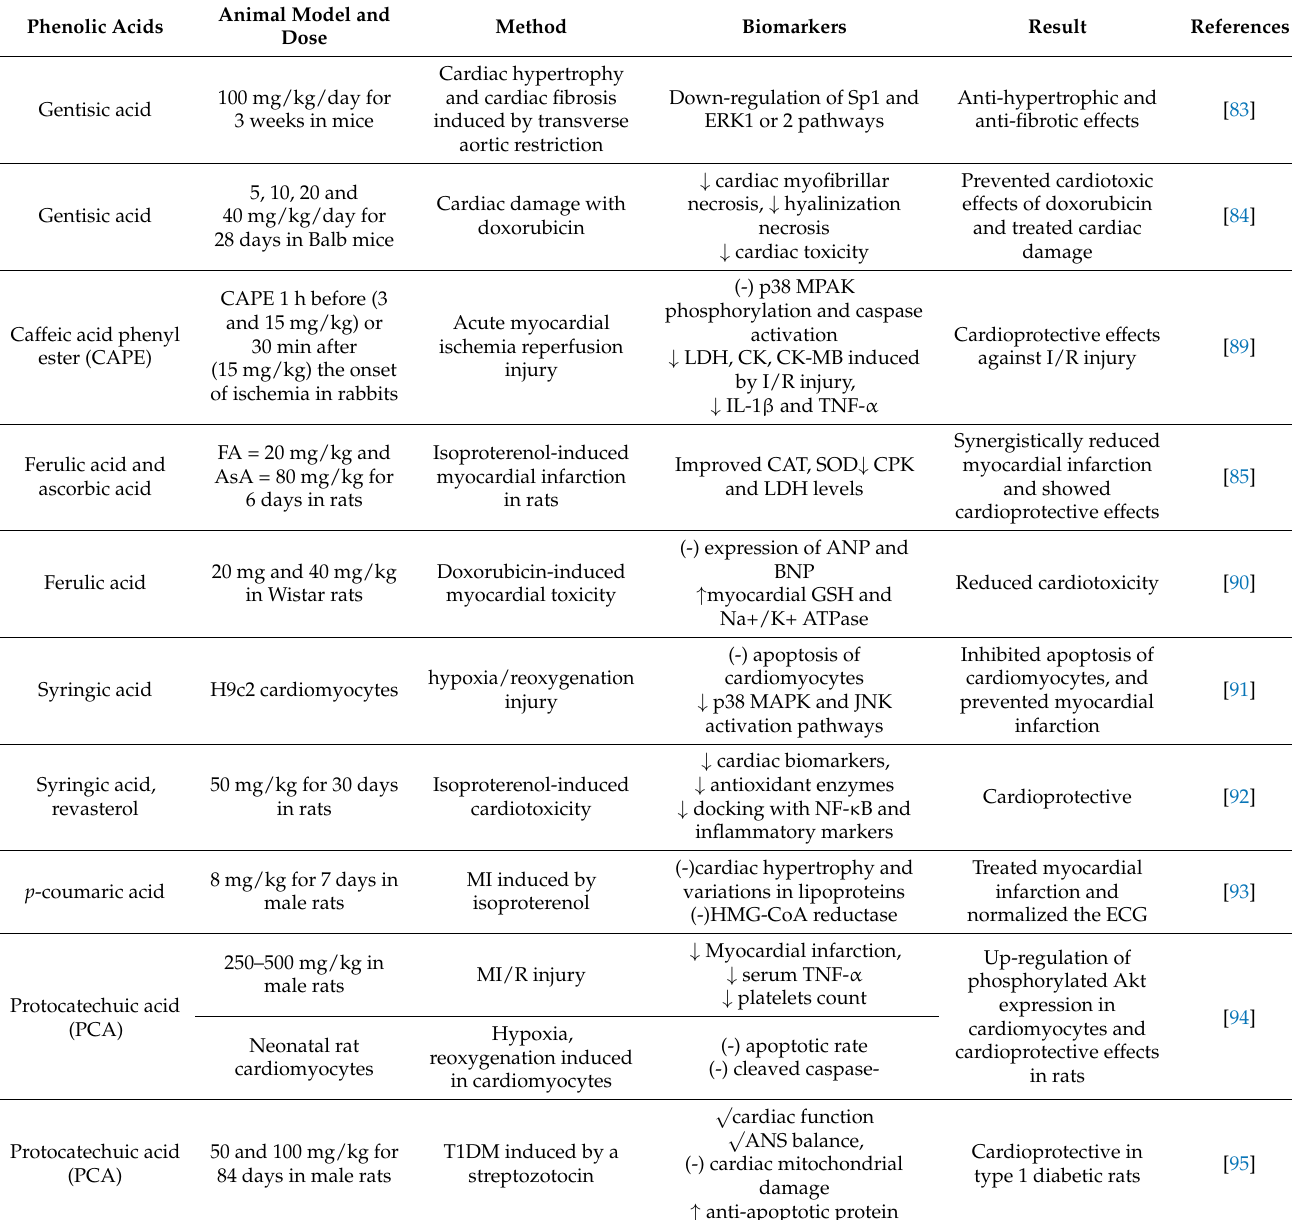
Table 4. Cardioprotective action of phenolic